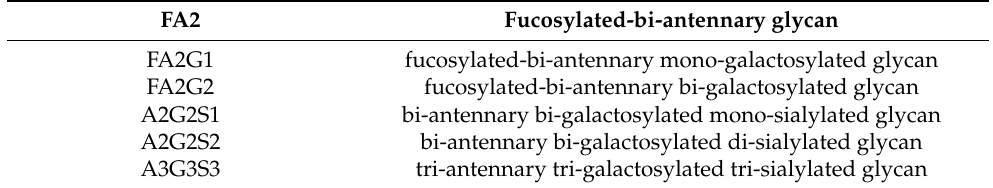
Figure 6. ( a ) Chromatograms of the glycan samples purified by cobalt ferrite and nickel ferrite; ( b ) Integrated peak areas of the chromatograms in case of the six most intensive glycan peaks. Table 4. The separated glycan types .